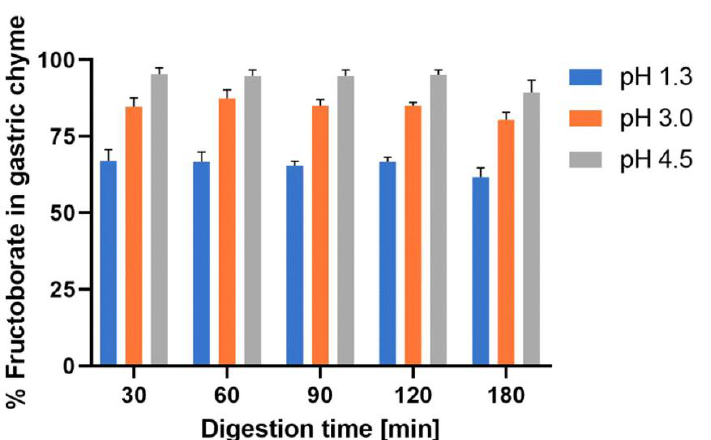
Figure 2. In vitro simulation of gastric digestion of NOB species (Part S2 [142 – 146]; Tables S1 and S2). NOB: Naturally organic